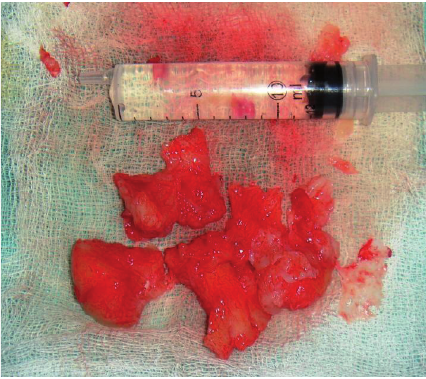
Figure 7: Gross appearance of the tumour mass.